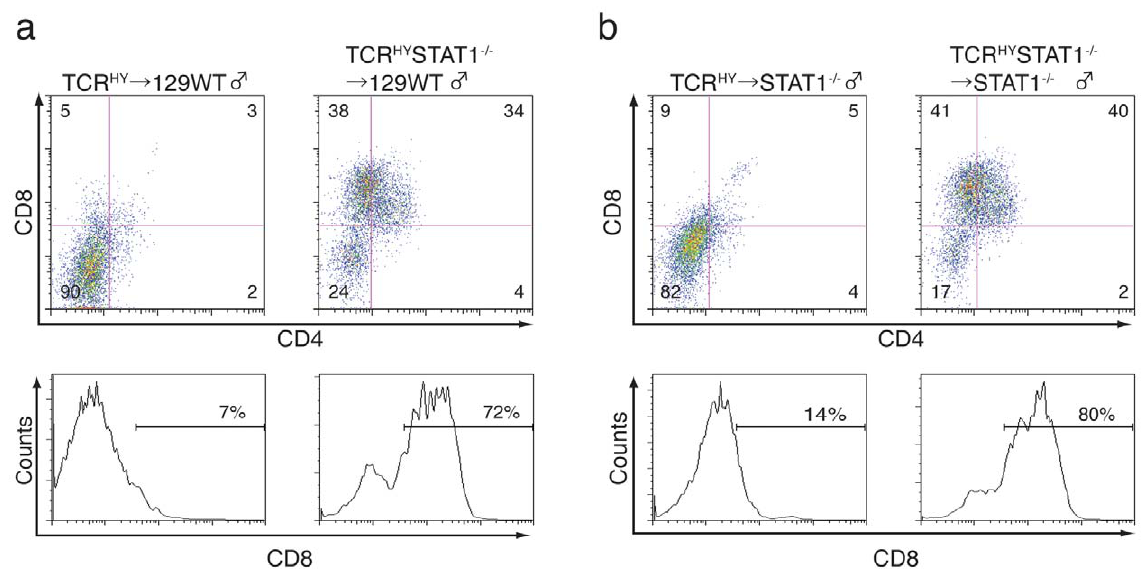
Figure 2. STAT1-deficient T cells fail to undergo deletion in the presence of wild type TEC. BM derived from TCR HY or TCR HY STAT1 2 / 2 animals was transferred into lethally irradiated male 129WT ( a ) or STAT1 2 / 2 mice ( b ). Thymi of recipient mice were analyzed 4 weeks post transfer. Upper panel: TCR HY thymocytes were gated and analyzed for CD4 and CD8 expression, and percentages of T cell subpopulations are indicated. Lower panel: histograms indicate percentages of TCR HY CD8 + cells. Representatives of at least three experiments are shown.